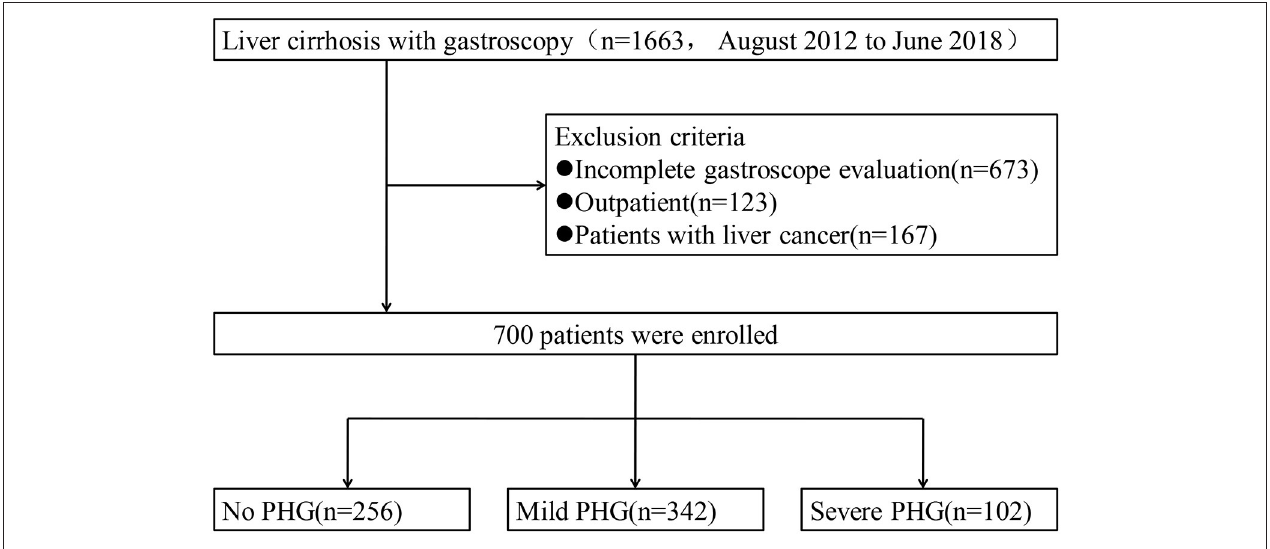
FIGURE 1 | The study flow